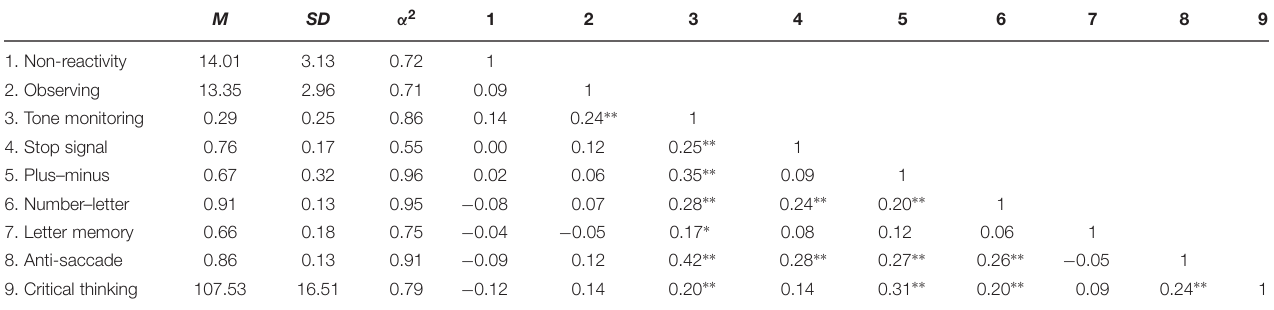
TABLE 1 | Descriptive statistics and correlations for mindfulness, executive functions, and critical thinking 1 .